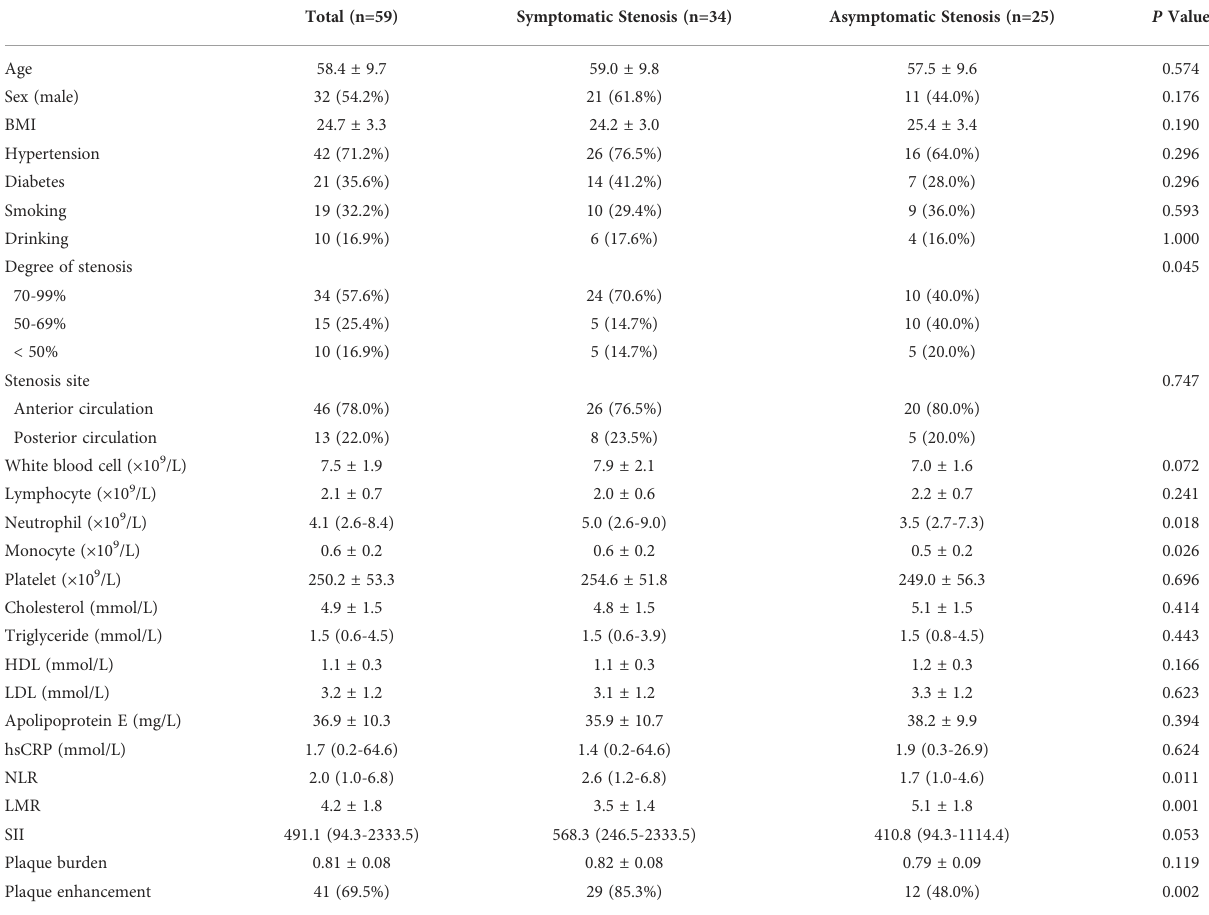
TABLE 3 Characteristics of ICAS plaques with and without